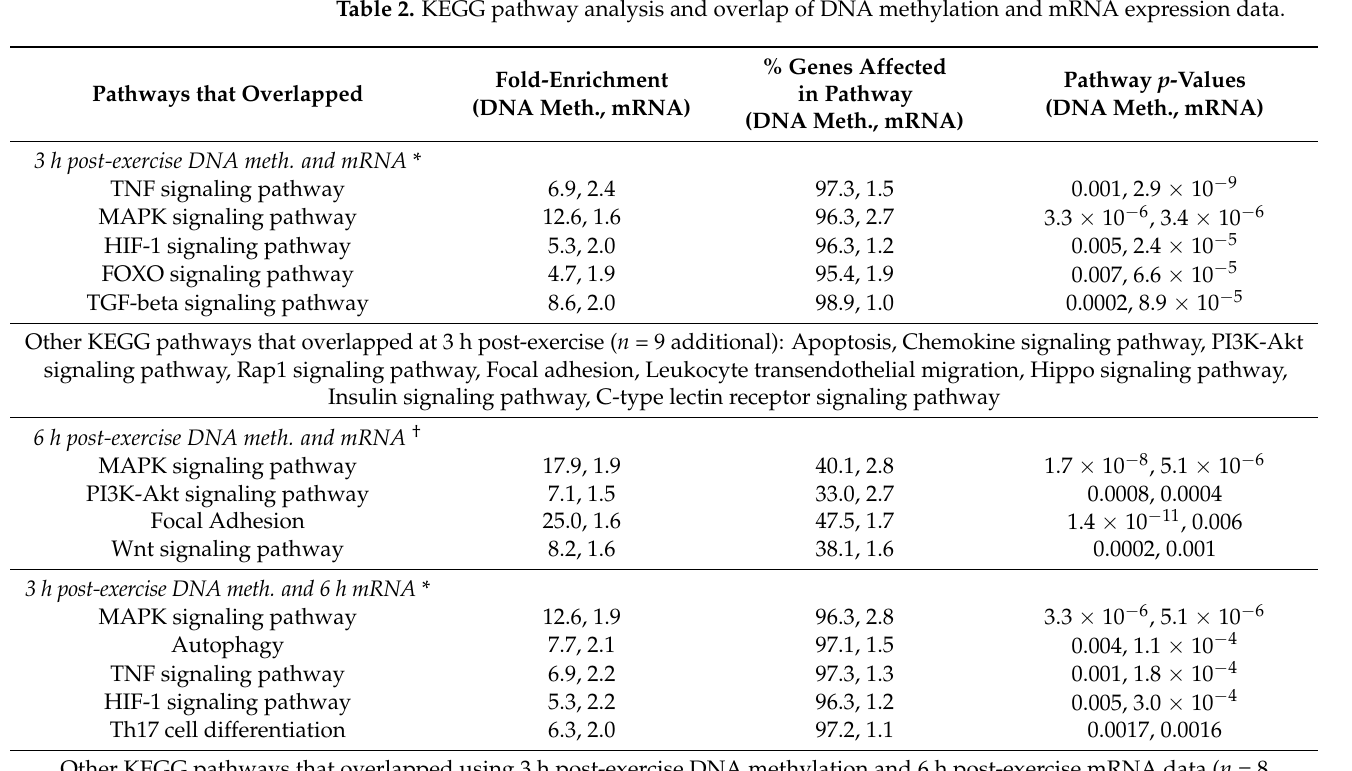
Table 2. KEGG pathway analysis and overlap of DNA methylation and mRNA expression